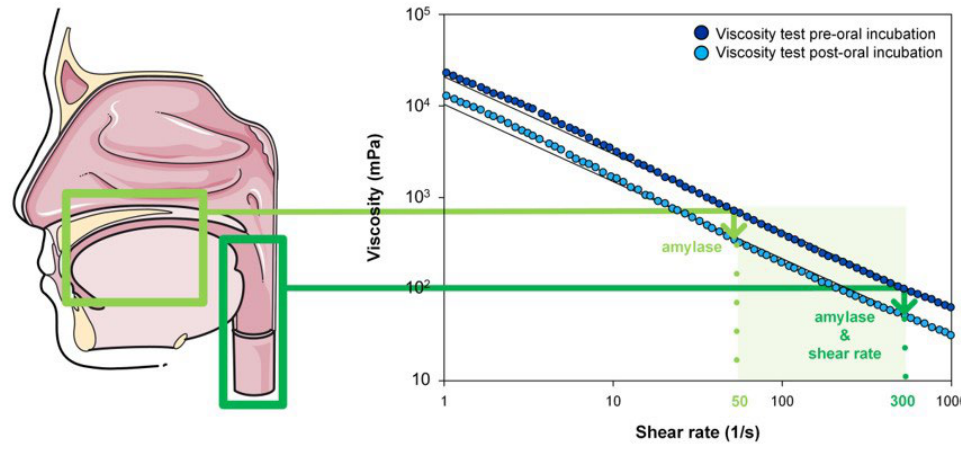
Figure 2. Salivary amylase and shear thinning effect analysis performed in a viscosity curve. Light green corresponds to the oral phase (salivary amylase effect at a shear rate of 50 s − 1 ). Dark green corresponds to the increment of shear rate from the oral to the pharyngeal phase (from 50 s − 1 to 300 s − 1 ), including the salivary amylase effect.